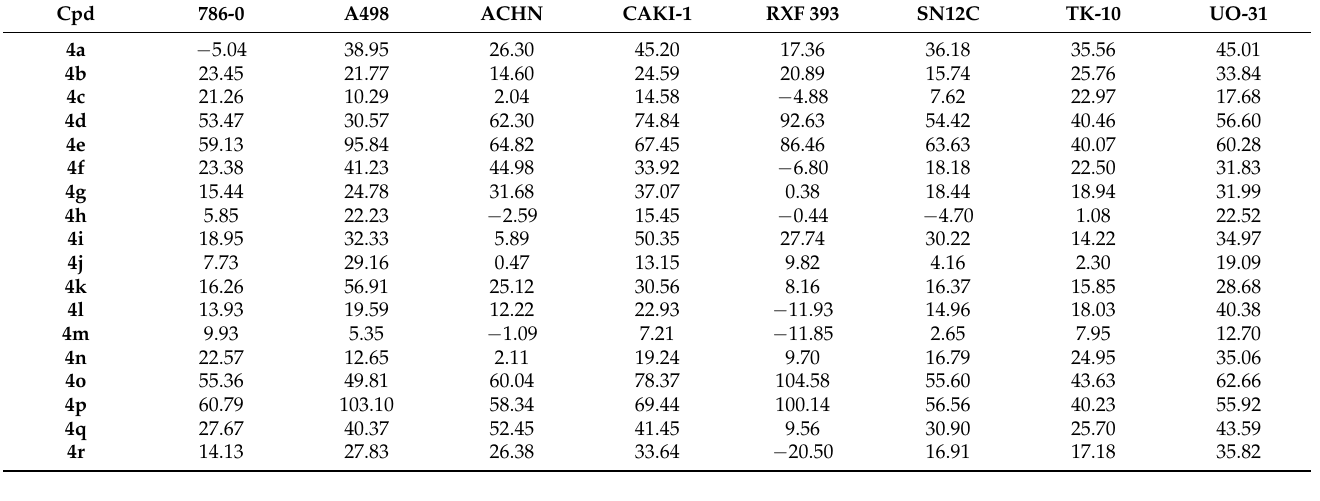
Table 11. Anti-proliferative activities (% growth inhibition) of the target compounds 4a ‒ r against renal cancer cell lines.